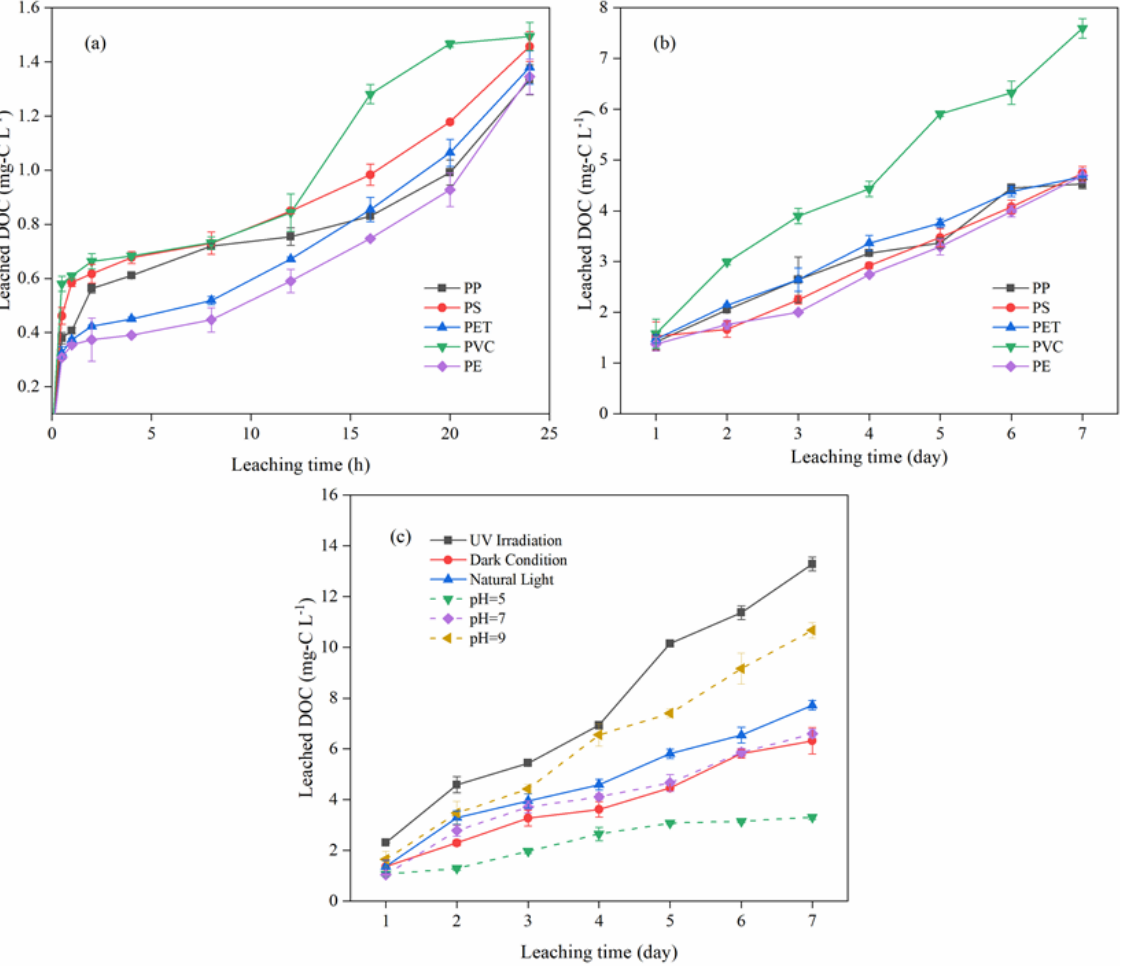
Figure 1. Variations with time in the concentrations of leached DOC for ( a ) 5 types of microplastics (PP, PS, PET, PVC, PE) in 24 h; ( b ) 5 types of microplastics in 7 days; ( c ) PVC microplastics under different light and pH leaching conditions in 7 days. The dose of added microplastics was 5.0 g L −1 .